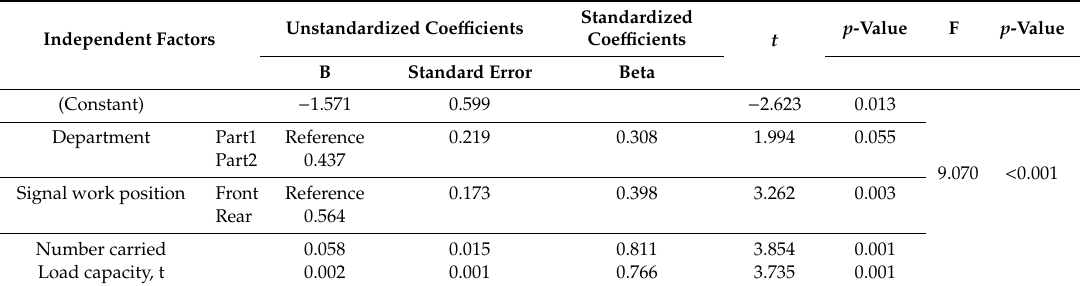
Figure 1. Exposure level of elemental carbon (EC), organic carbon (OC), and total carbon (TC) by date of measurement. The box represents the interquartile (IQ) range which contains the middle 50% of the records and whiskers indicate 10th and 90th percentiles. Outliers (circles, ◦ ) are cases with values between 1.5 and 3 times the IQ range. Extremes (asterisks, *) are cases with values more than 3 times the IQ range. Table 3. Multiple regression analysis results to predict natural log-transformed EC